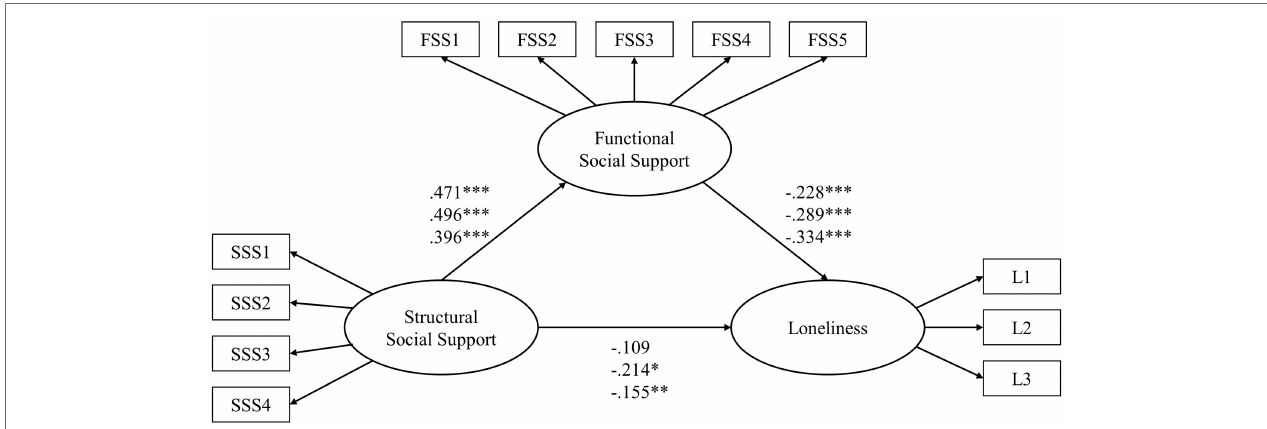
FIGURE 2 | Mediation models for older adults in cities, towns, and rural areas. The three values from top to bottom on each path represent parameters corresponding to the models for older adults in cities, towns, and rural areas. SSS, structural social support; FSS, functional social support; and * p < 0.05, ** p < 0.01, and *** p <